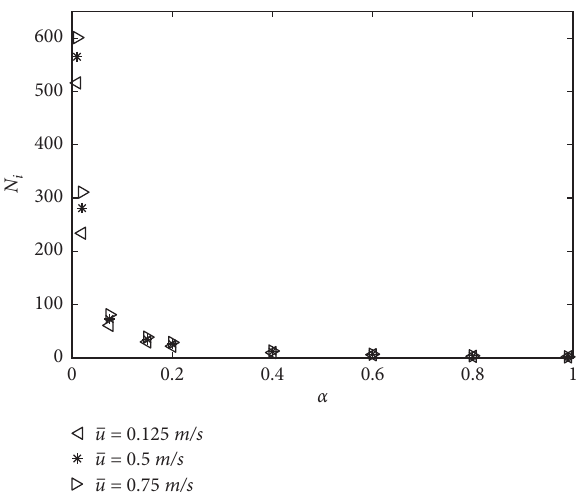
Figure 4: The variation of N i (number of iterations needed for the numerical solution to converge) with respect to α under different average velocities of the incoming flow.